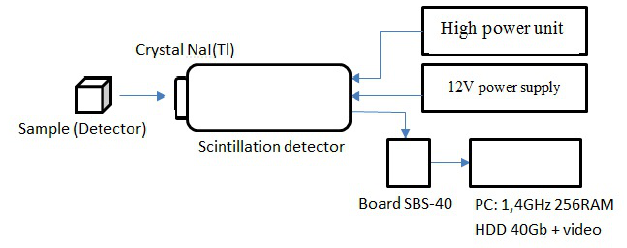
Fig. 2. Schematic of the scintillation spectrometer. The measured energy resolution (FWHM) of the spectrometer for calibration lines and the simulated total peak efficiency ε for the detected gamma lines of the neutron - activated sample 59Co are shown in Table I.